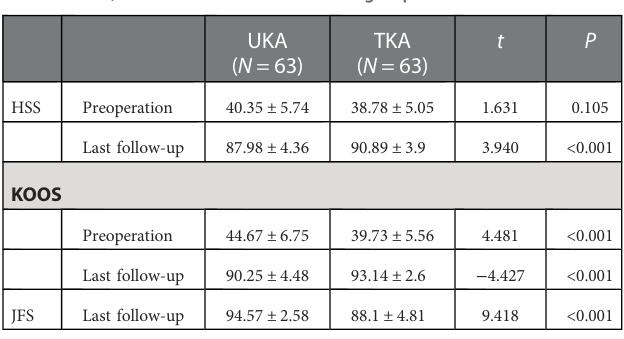
TABLE 5 Local complications.